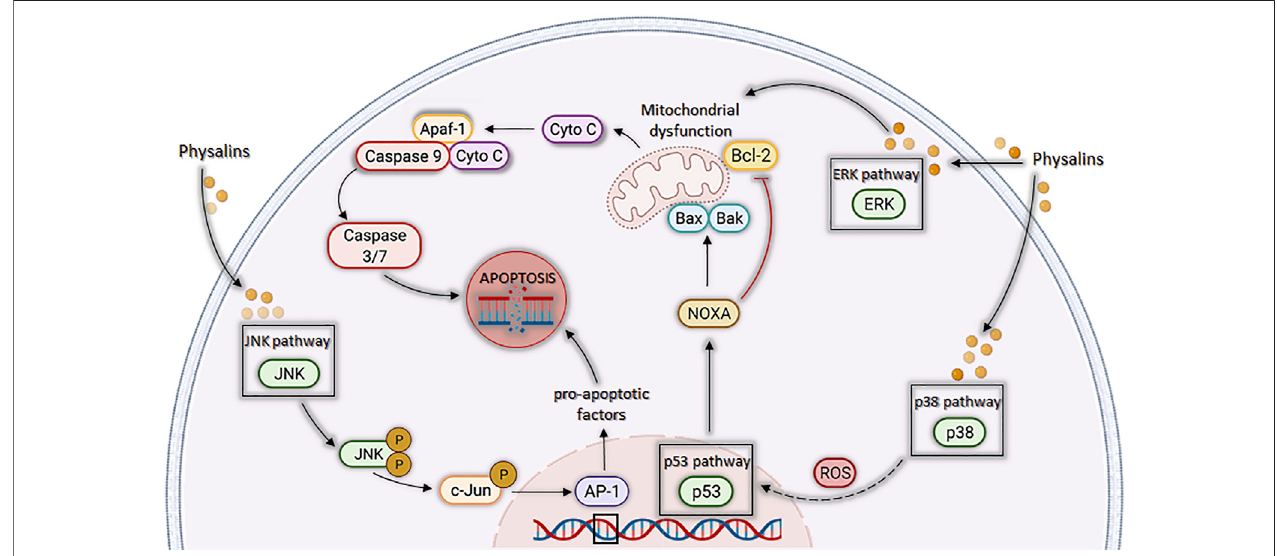
FIGURE4| Celldeathbyapoptosisisinducedbyphysalinsthroughdifferentpathwaysrelated tomitogen-activatedprotein kinase(MAPK).Physalinsincrease the phosphorylation levels of ERK1/2, JNK, and p38 MAPK. ERK1/2 activation induces mitochondrial ROS (mTOR) production, leading to the release of cytochrome c and activationofcaspases3,6,and9,triggeringapoptosis.JNKactivationpromotesthephosphorylationofc-Jun,whichleadstotheformationofactivatorprotein1(AP-1), a protein that regulates the transcription of pro-apoptotic factors and leads to apoptosis. P38 activation results in increase of ROS levels, which leads to p53 activation,whichinturnincreasesthetranscriptionofpro-apoptoticproteins,suchasNoxa,BAX,andBAK,anddecreasesthetranscriptionoftheanti-apoptoticBCL-2 protein, leading to apoptosis through the mitochondrial